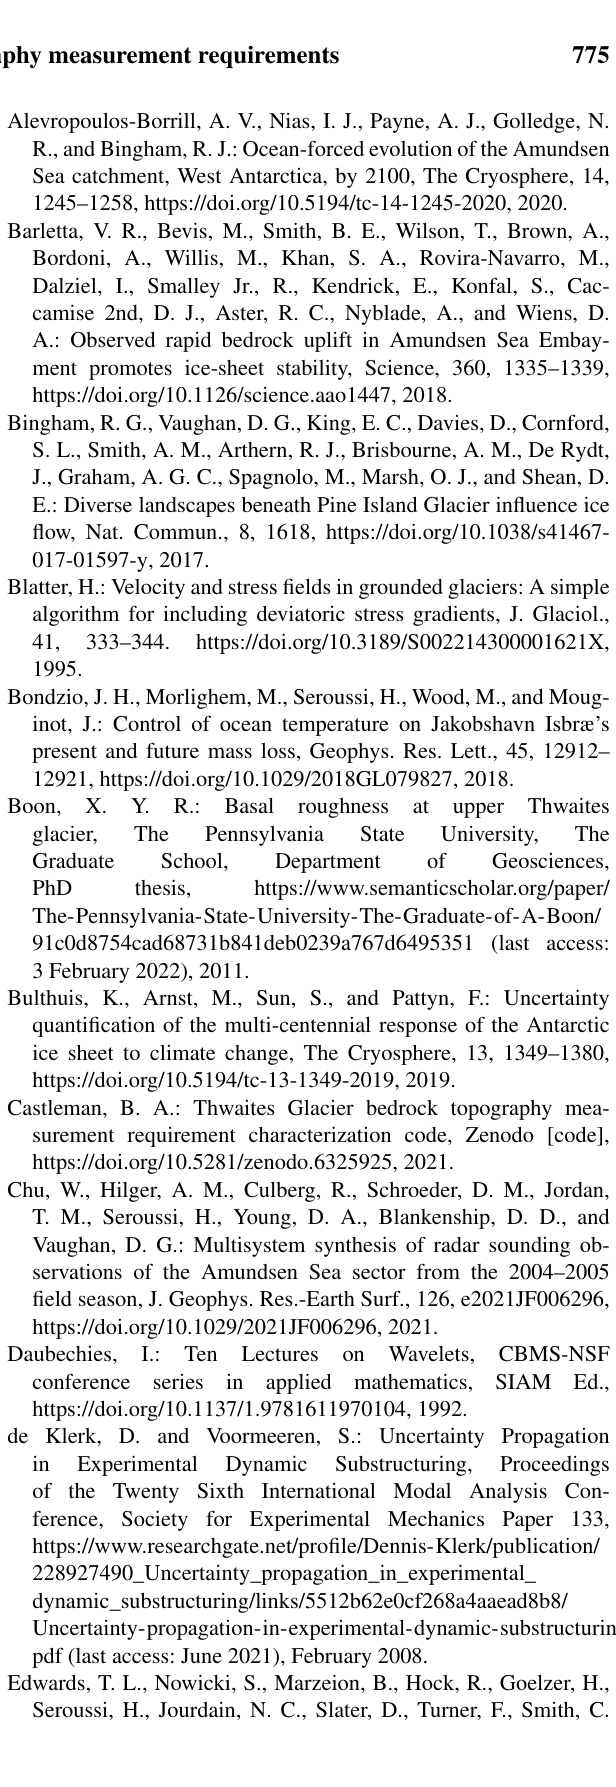
Figure 3 is made using shaded percentile plotting by Onofrey